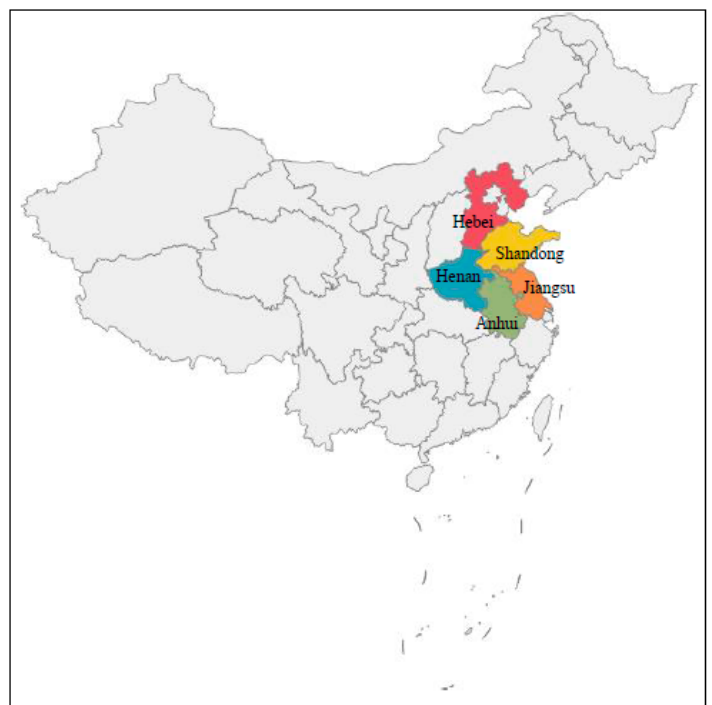
Figure 1. Location map of sample provinces in China.